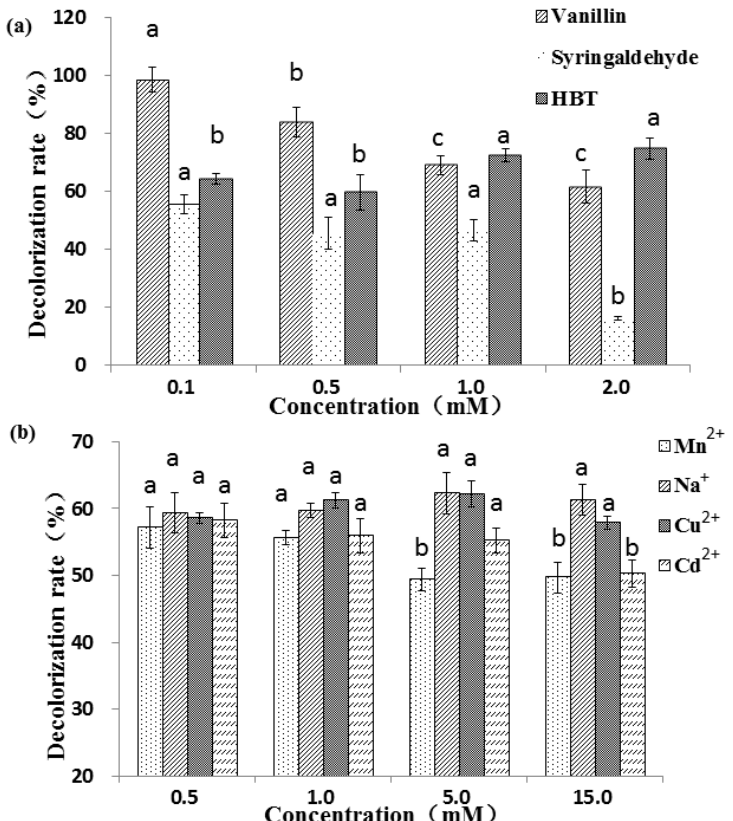
Figure 3. Decolorization percentage of RBBR under three mediators ( a ) and four metal ions ( b ). The final laccase activity of the reaction system was 1000 U L − 1 . Decolorization percentage was determined by measuring changes in absorbance at 592 nm. Reaction condition: pH 4.5, dye concentration 200 ppm, temperature 30 ◦ C, and reaction time 30 min. The error bars represent the standard deviation of triplicate samples. Di ff erent letters above bars indicate statistically significant di ff erences between groups according to one-way ANOVA ( n = 3, p < 0.05; refer in-text for test specifics and test